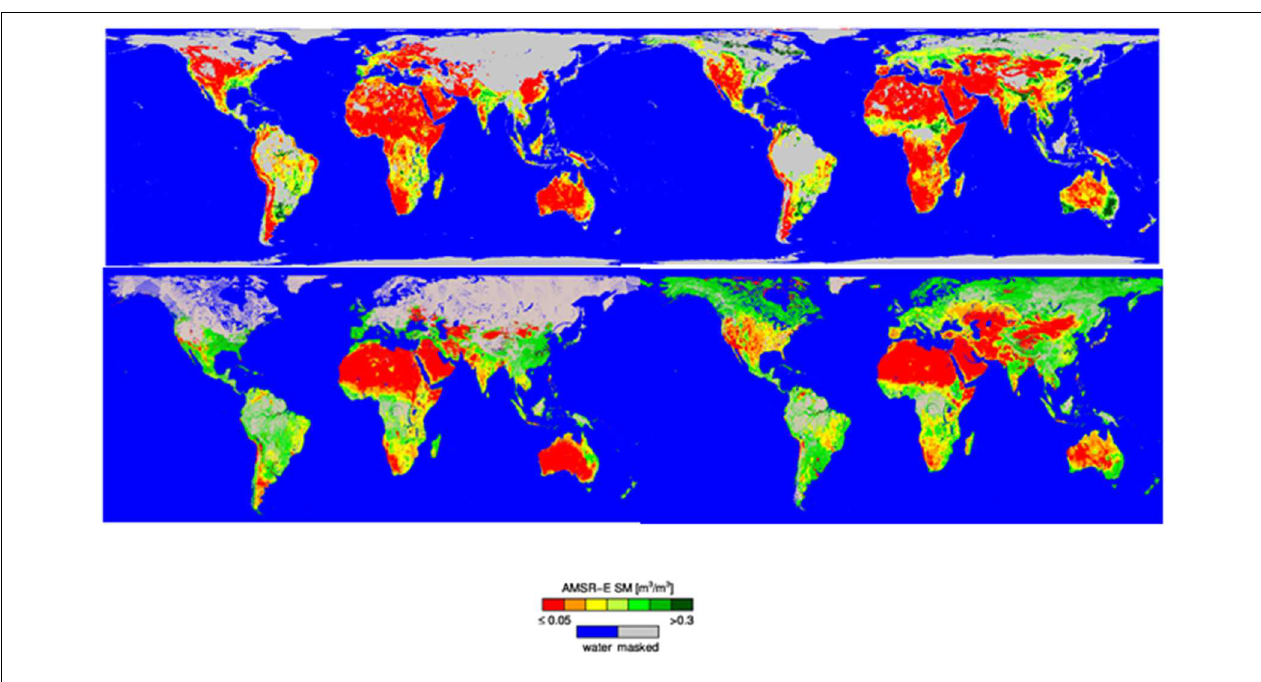
are shown during Northern Hemisphere winter (January 2003), and on the right they are shown during Northern Hemisphere summer (July